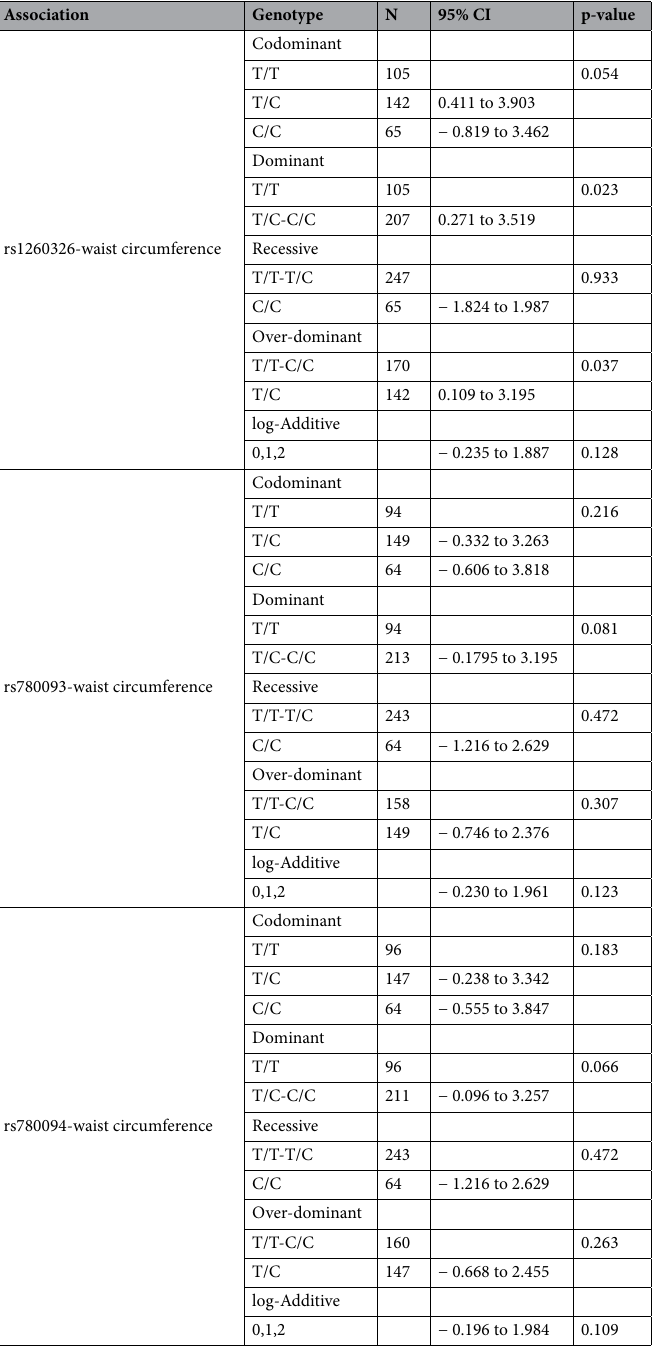
Table 4. Association between GCKR SNPs and waist circumference. CI confidence interval, GCKR glucokinase regulator, SNP single nucleotide polymorphisms.